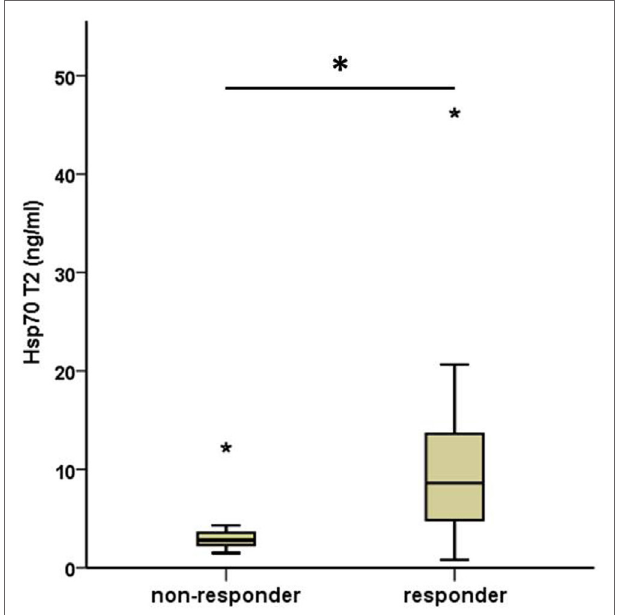
FigUre 3 | Comparison of median post- (T2) therapeutic heat shock protein 70 (Hsp70) plasma levels in non-responding and responding non-small-cell